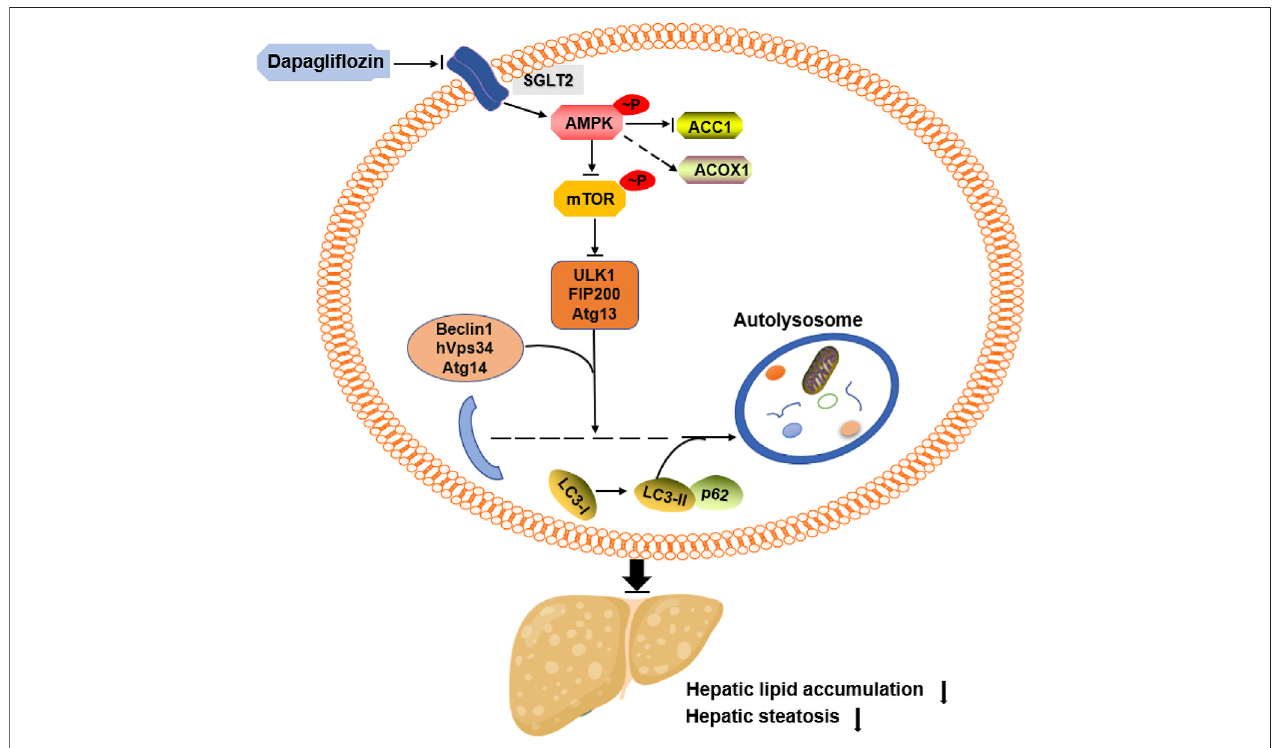
FIGURE 6 | Summary of the underlying mechanism of dapagli fl ozin on alleviating hepatic steatosis.